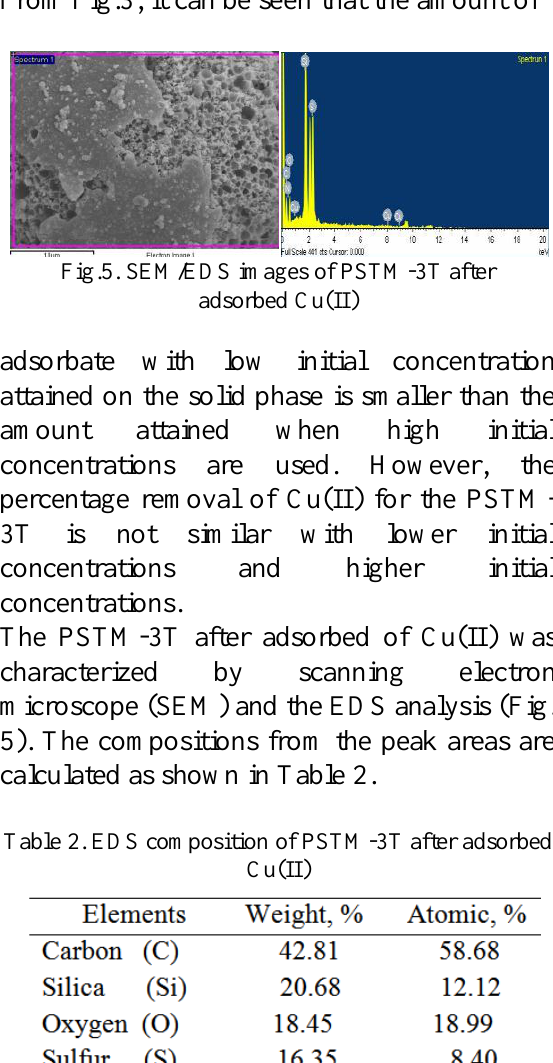
Fig. 4. Relative concentration of Cu (II) species in a system containing 1*10 -4 mol/l Cu(II); from Schneider (1995).